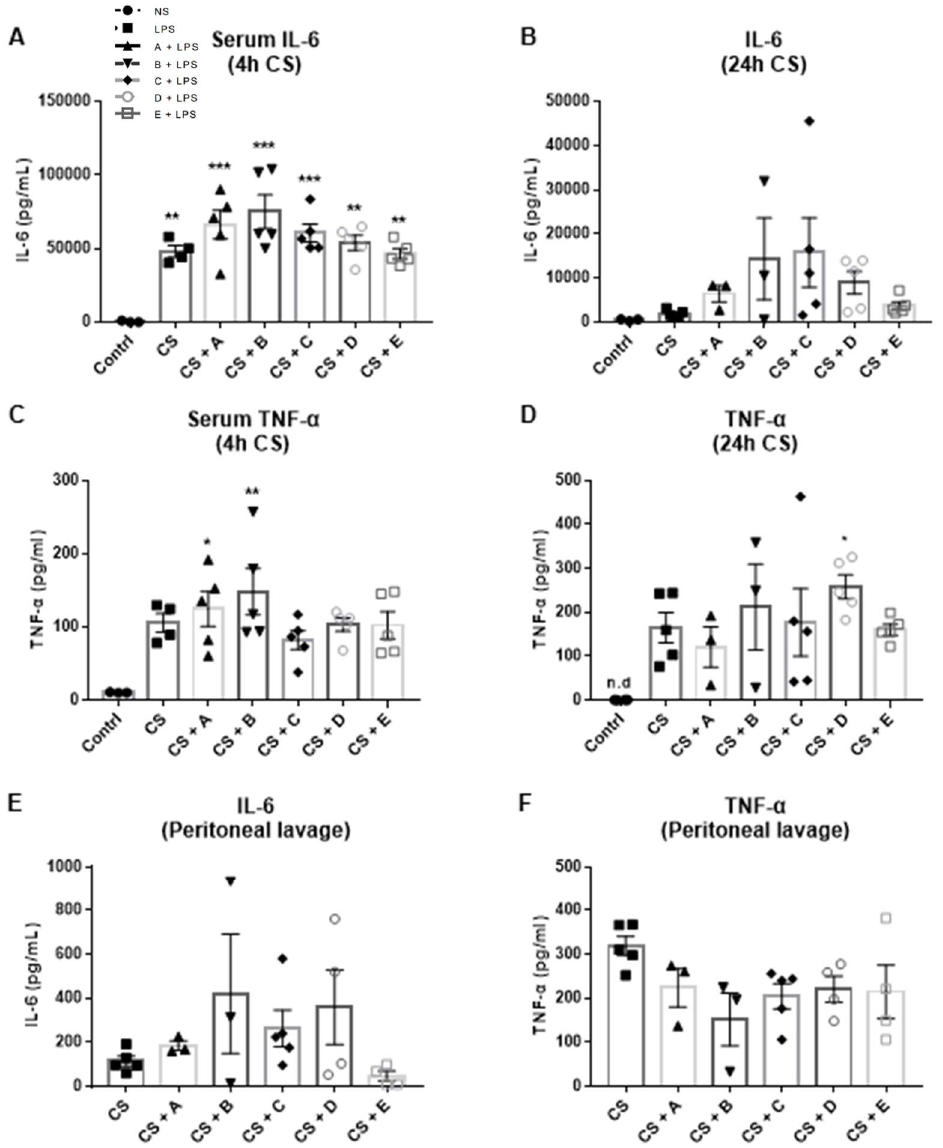
Figure 4. Effect of the Greek honey on CS-induced inflammation: serum ( A , B ) IL-6 and ( C , D ) TNF- α levels measured 4 and 24 h after cecal slurry injection; ( E ) IL-6 and ( F ) TNF- α levels in the peritoneal lavage of septic mice. All graphs represent measurements from 5 mice per group and show the mean ± SEM. In the post-hoc test, the dextrose-injected group (contrl) was selected as the control group for multiple comparisons with the honey-treated groups: * p < 0.05, ** p < 0.01, and *** p < 0.001, CS-injected vs. control group. The absence of an asterisk indicates no statistical significance. A: Epirus arbutus; B: Evros chestnut; C: Epirus fir; D: Crete fir; E: Manuka honey.